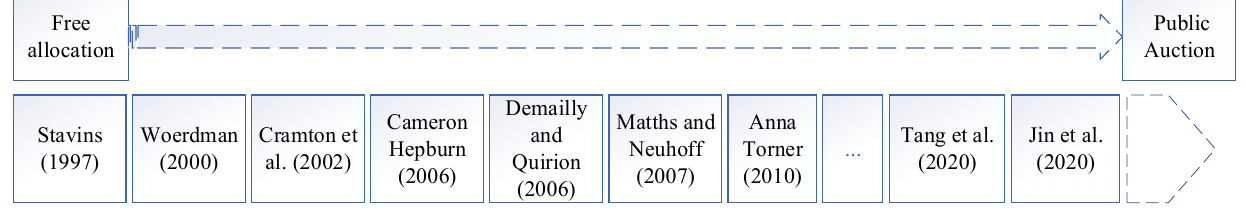
Figure 9. Scholars of study free allocation and public auction [43–56].